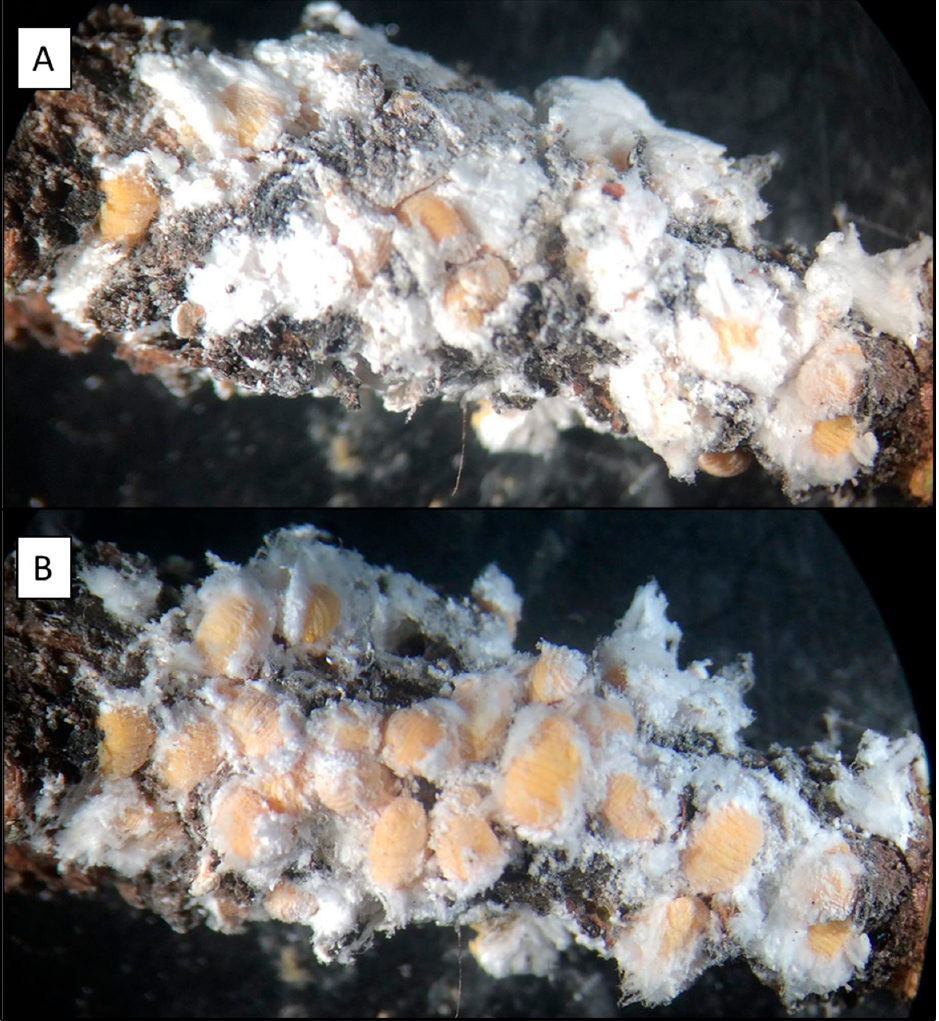
Figure 1. Pinus radiata twig, collected from CRP in March 2019, measuring 1.6 cm × 4.0 cm, and infested with 2nd instar stage Marchalina hellenica . Images show the same infested twig after excising ( A ) and after flocculent was removed ( B ). In view are 34 individual 2nd instar nymphs at a density of 0.60 GPS cm − 2 .